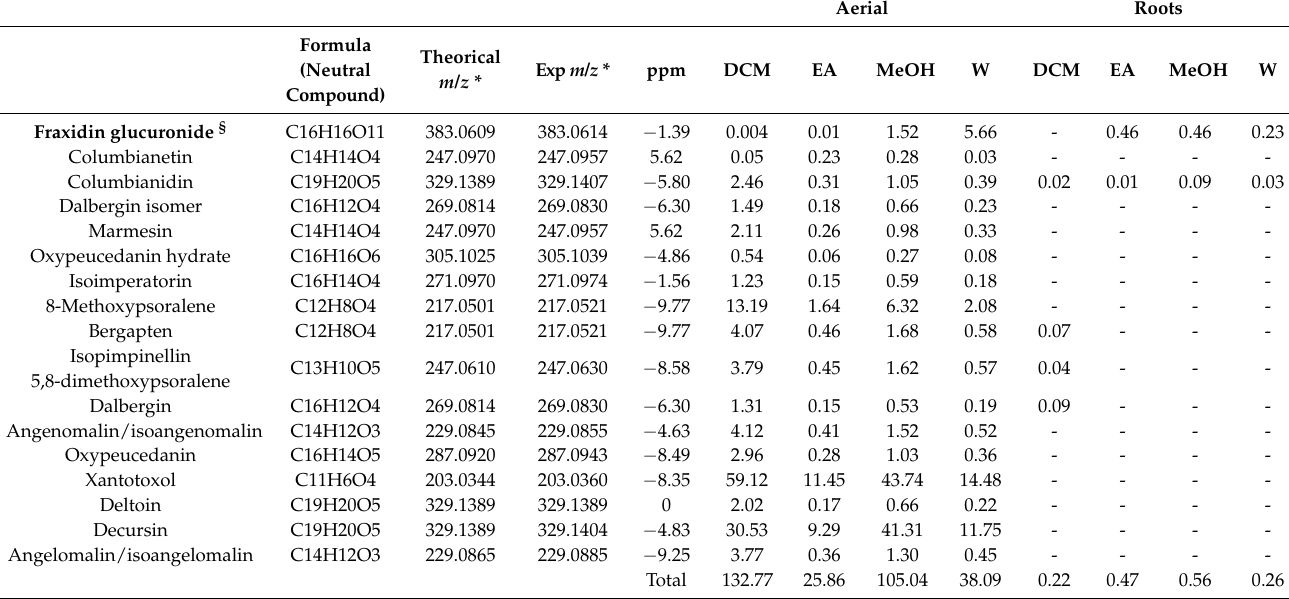
Table 5. Content of coumarins identified and quantified in the extracts, expressed as mg/g on dry extract. MS data were acquired in positive ion mode